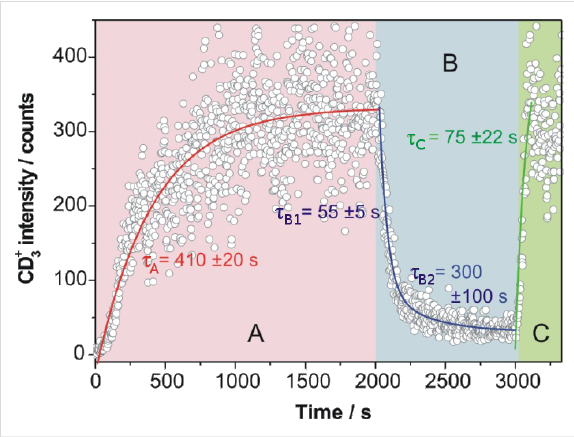
Figure 3: Time evolution of the integral CD 3+ intensity (open circles) during the continuous admission of CD 3 I to a 10 ML Au film on Mo(100). The surface temperature was 120 K. At 2000 s the gas admission was stopped for 1000 s. The solid lines represent the best fits to the different parts of the measured data (A, B and C) with expo- nential growth and decay functions, as appropriate (see text for more details). Pump pulse: 266 nm, 2 mW/cm²; probe pulse: 333 nm, 600 mW/cm²; pump–probe delay time: 130